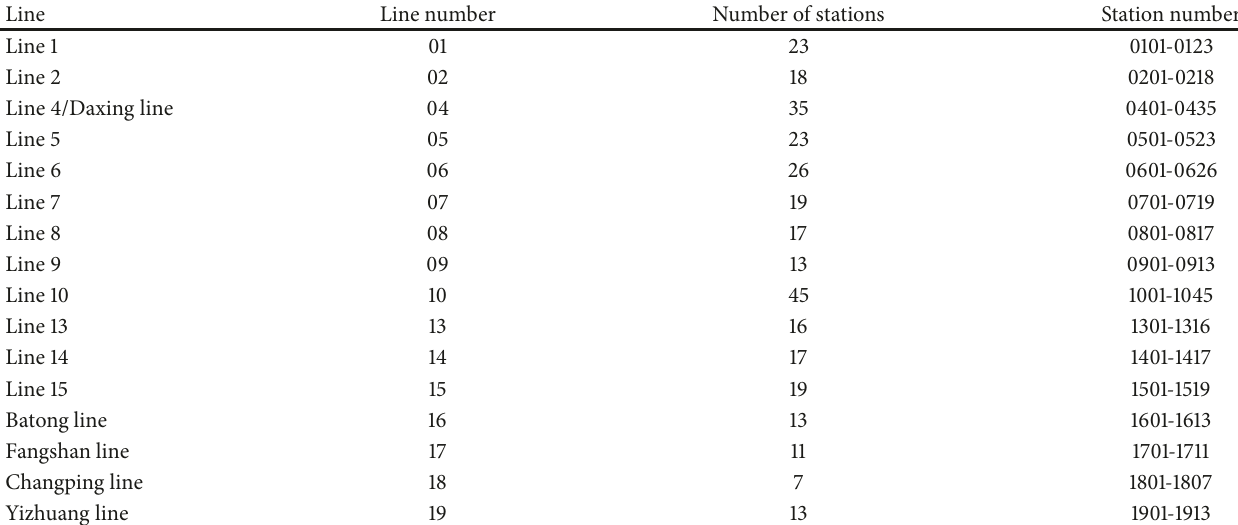
Table 2: Information for the Beijing Urban Railway